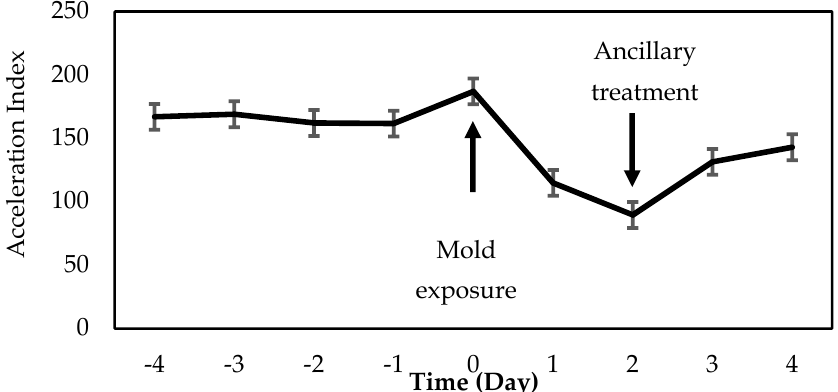
Figure 4. Mean daily accelerometer readings from the HerdDogg accelerometer over a 9-d period, before and after mold contaminated feed was fed to ewes. Day 0 was the day ewes were exposed to the feed (indicated by arrow) and day 2 was the day treatment for symptomatic ewes began, following a veterinarian directed protocol (indicated by arrow). Error bars represent standard errors.